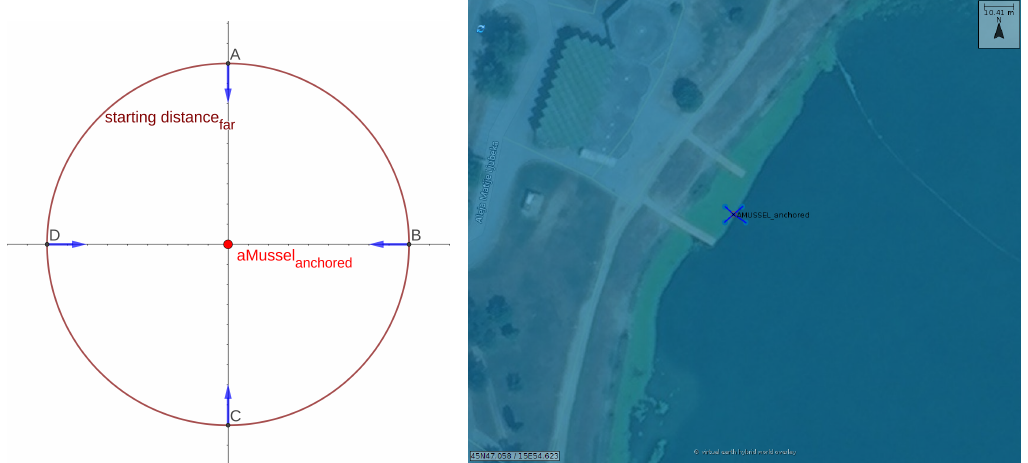
Figure 18. Starting positions for docking attempts around an anchored aMussel as envisioned ( left ) and marked as goalpoints in the aPad mission supervision and control framework ( right